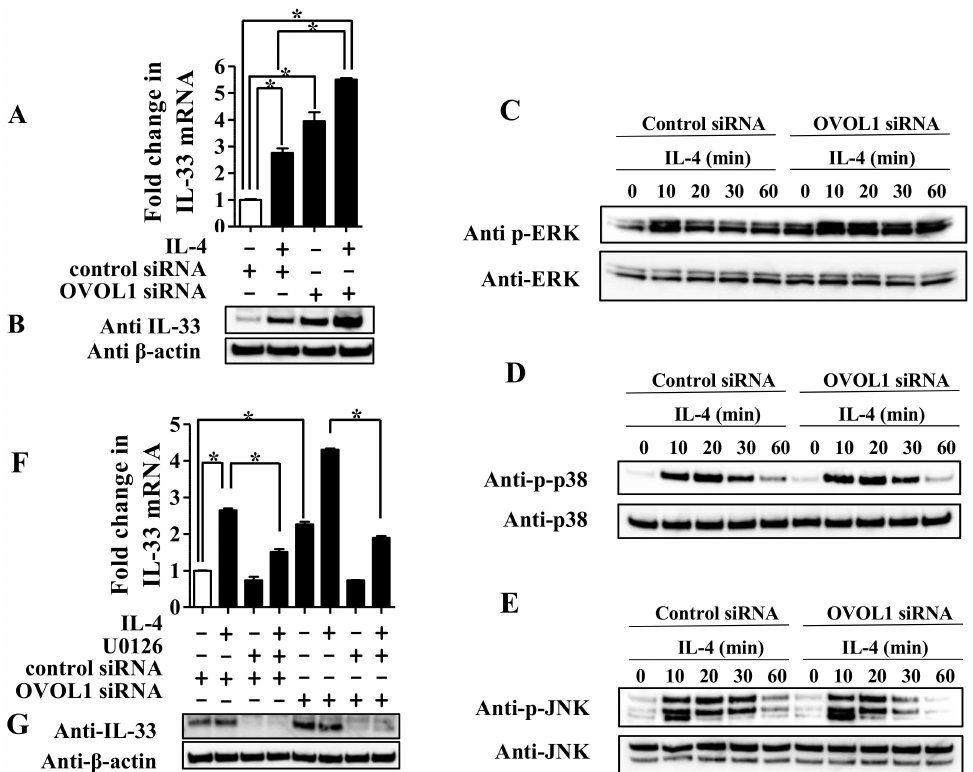
Figure 4. ( A , B ) NHEKs were transfected with control siRNA (si-control) and siRNA against OVOL1 (si-OVOL1) and subsequently treated with IL-4 (10 ng / mL) for 24 h. ( A ) IL-33 expression was analyzed by qRT-PCR. ( B ) IL-33 expression was analyzed by Western blotting with an anti-IL-33 antibody. NHEKs transfected with either si-control or si-OVOL1 were treated with IL-4 (10 ng / mL) for the indicated period and subjected to Western blotting analysis with an anti-phosphorylated ERK-1 / 2 and anti-ERK-1 / 2 antibody ( C ), anti-phosphorylated p-38 and anti-p38 antibody ( D ), or anti-phosphorylated JNK antibody and anti-JNK antibody ( E ). ( D , E ) NHEKs transfected with either si-control or si-OVOL1 were treated with IL-4 (10 ng / mL) for 24 h in the presence or absence of U0126. ( F ) IL-33 expression was analyzed by qRT-PCR. ( G ) IL-33 expression was analyzed by Western blotting with an anti-IL-33 antibody. ( A , F ) Data are expressed as mean ± S.E.M.; n = 3 for each group; * p < 0.05. ( C – E , G ) The data are representative of experiments repeated three times with similar